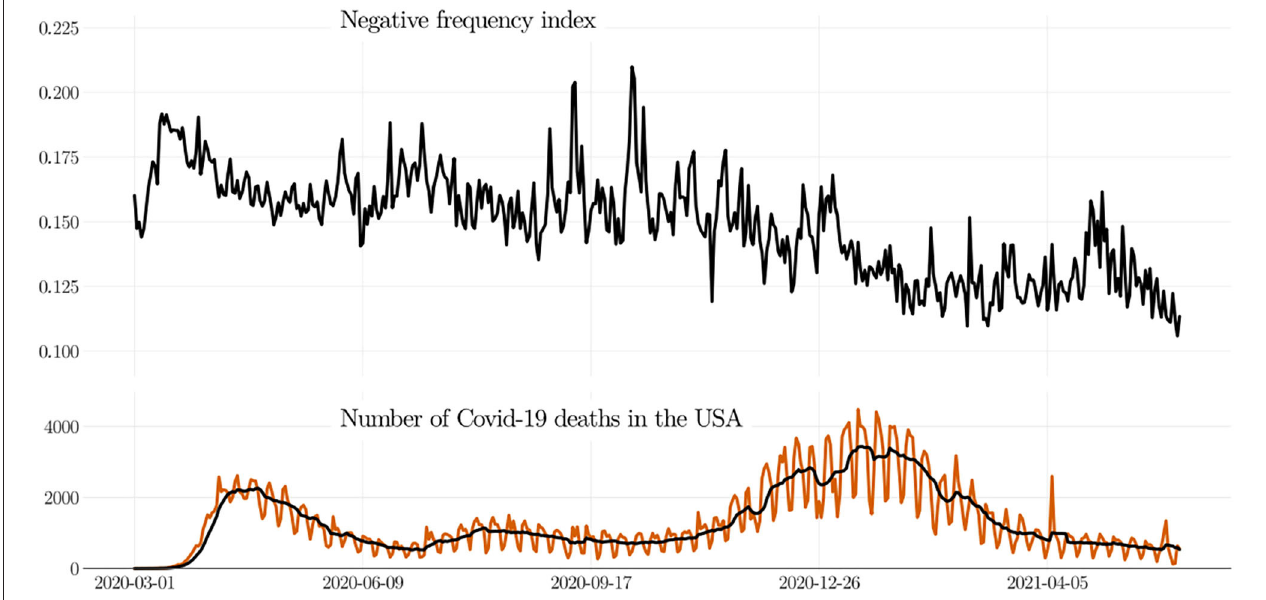
FIGURE 3 | Negative frequency index (negative perception in tweets) and the statics of COVID-19 deaths in the USA (death data from Hasell et al., 2020). Although the USA accounts for around 42.5 % of all tweets (e.g., Garcia and Berton, 2021), the negativity decreased when the number of deaths skyrocket in the end of 2020, a paradox that seems to be driven by psychophysical numbing